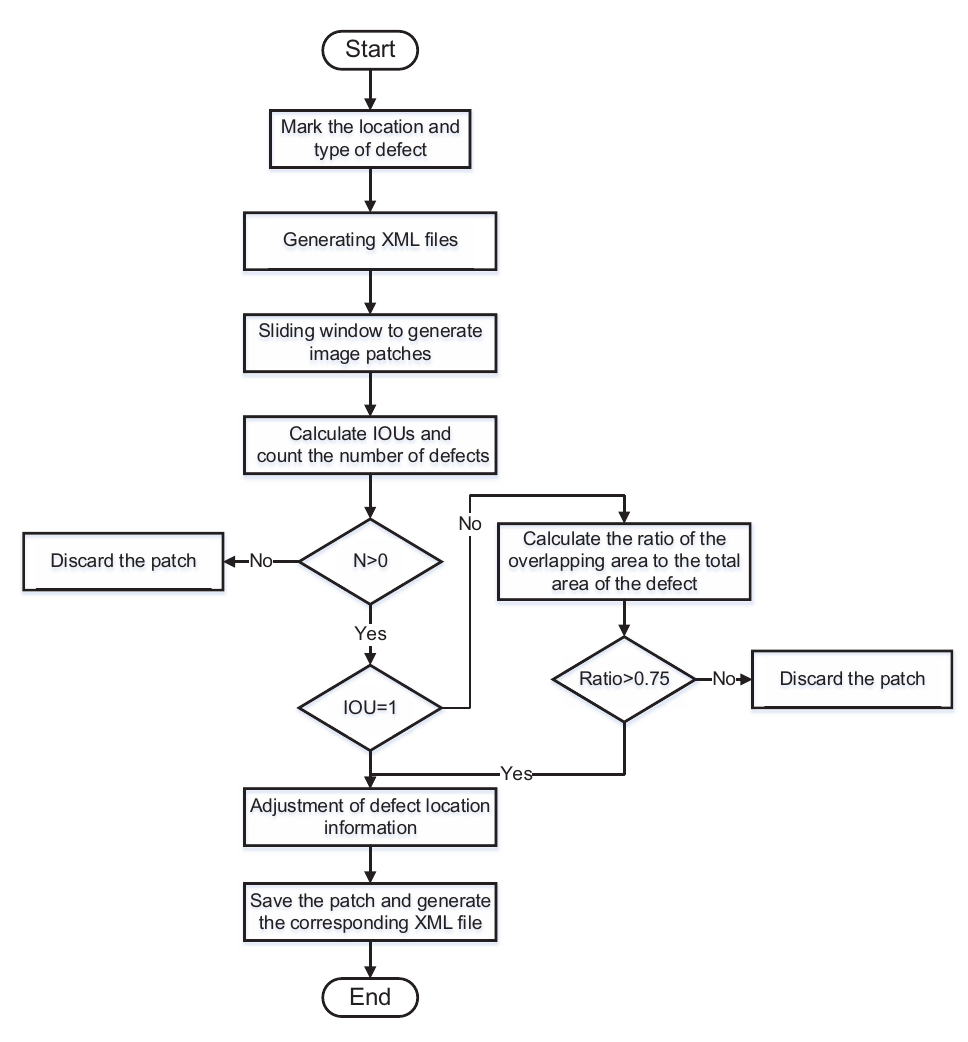
Figure 6. Flowchart of dataset processing. First, we use the labelling tool LabelImg to label the rectangular box in the target area of the defect. We experimentally set the initial size of the sliding window to 400 × 400 and the step size to 200. The algorithm reads the annotation file of each image, gets the location and category information for each defect in the image, and traverses the image starting from the top left corner of the image. The algorithm first determines whether there is a defective target in the area of the window. If there is no defect, the cropped image is discarded. Otherwise, the defect area information is saved. Then, the algorithm determines whether there is a window containing an incomplete defect. If not, the defect location information is converted to the image coordinate system of the window and saved to generate a new annotation file. When there is an incomplete defect area, the algorithm calculates the ratio of that defect area in the window to the area of the actually marked defect. When the ratio is greater than 0.75, the annotation information of the defect is adjusted and the window boundary is used as the new boundary. When the ratio is less than 0.75, the defect is discarded, and the window image is then saved and a new annotation file is